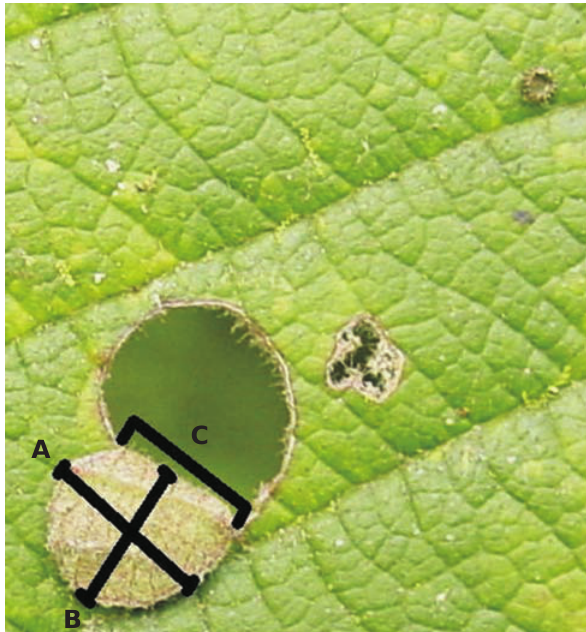
Figure 1. Photograph of first larval shelter of Noctuana haematospila in eastern Ecuador. Lines indicate the dimensions recorded for both first and second larval shelters: a) length of shelter lid parallel to the shelter bridge, b) width of the shelter bridge perpendicular to prior measurement, c) bridge